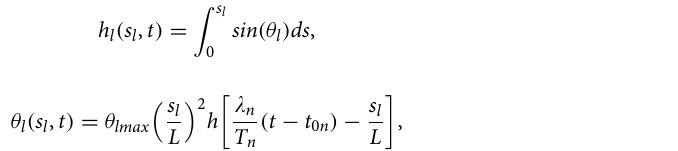
deflection angle at the trailing edge, (cid:31) n is the wavelength, T n is the period, t is the time, t 0 n